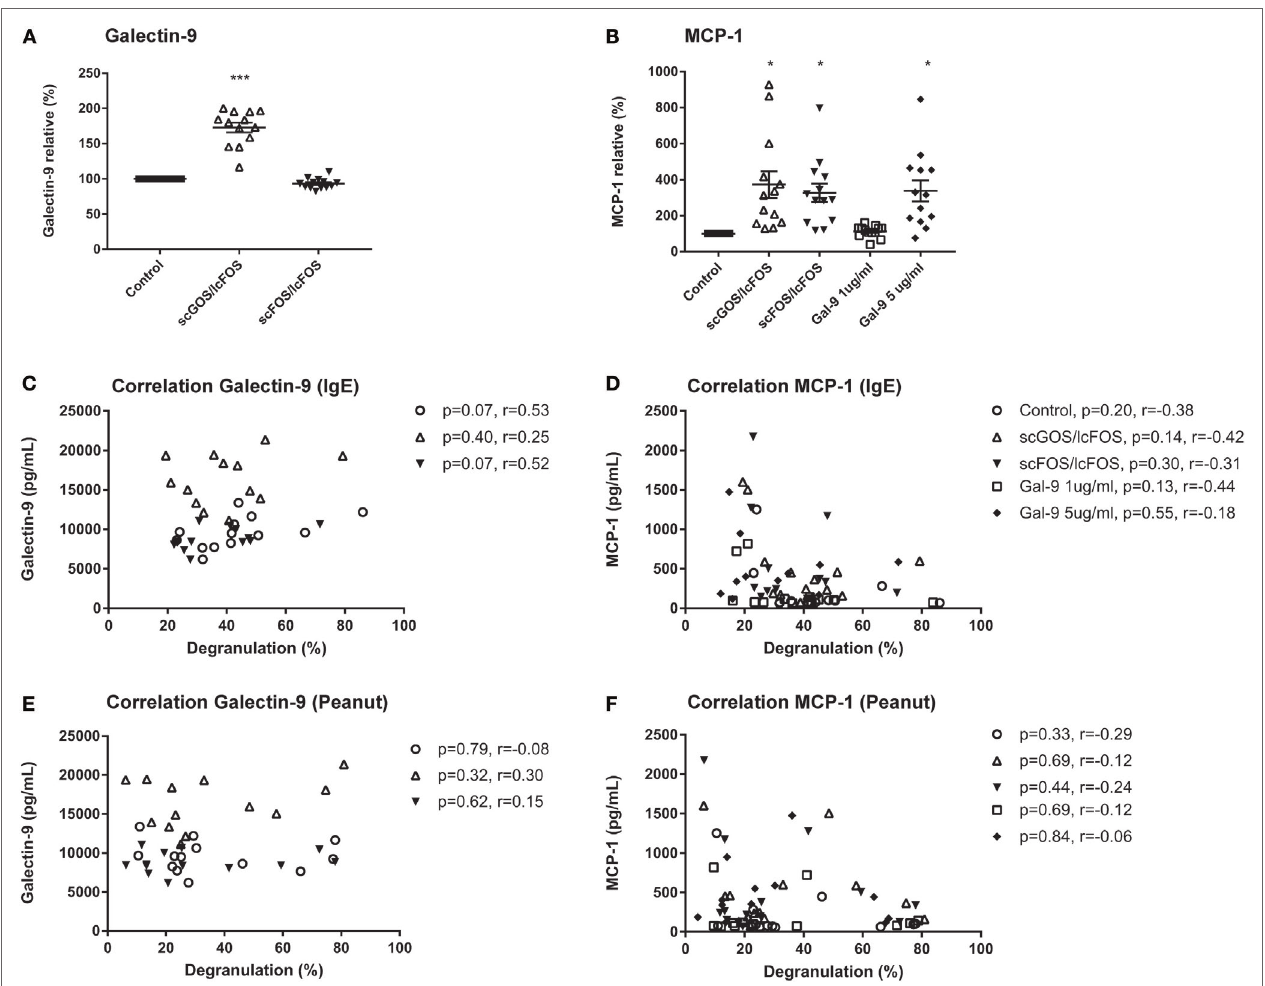
FigUre 4 | No correlation between relative basophil degranulation and galectin-9 or MCP-1 production. Galectin-9 increased in short-chain galacto- oligosaccharides and long-chain fructo-oligosaccharides (scGOS/lcFOS) pre-incubated samples, and were above the detection limit for galectin-9 treated samples (a) . MCP-1 (CCL2) was increased after pre-incubation with both non-digestible oligosaccharides and 5 µg/mL galectin-9 (B) . This was not correlated with anti-IgE or peanut-specific basophil degranulation (c–F) . Data are represented as mean ± SEM of n = 15 patients. * P < 0.05, *** P < 0.001 by one-way ANOVA. Correlation was tested with Pearson correlation